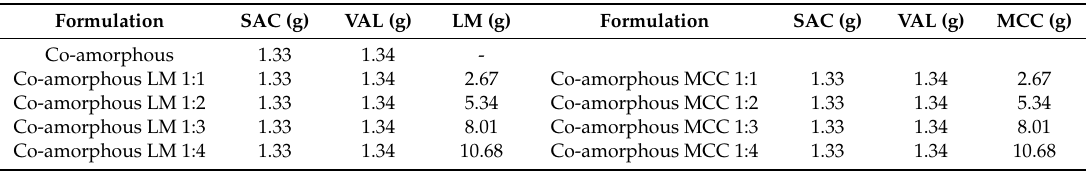
Table 1. Spray-dried co-amorphous solid dispersion (SD) preparation compositions. Lactose monohydrate (LM), and microcrystalline cellulose